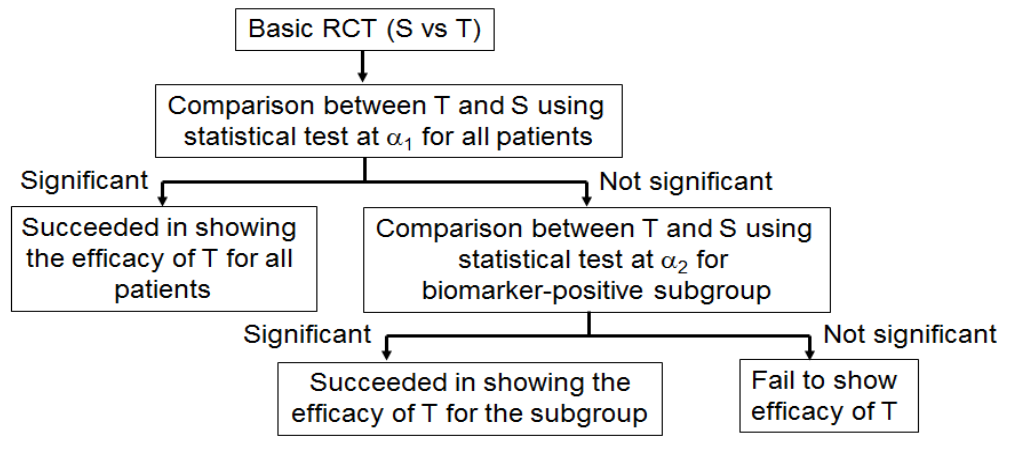
Figure 5. General procedure for adaptive signature and biomarker-adaptive threshold designs. ‘S’ and ‘T’ denote the standard and test treatments,